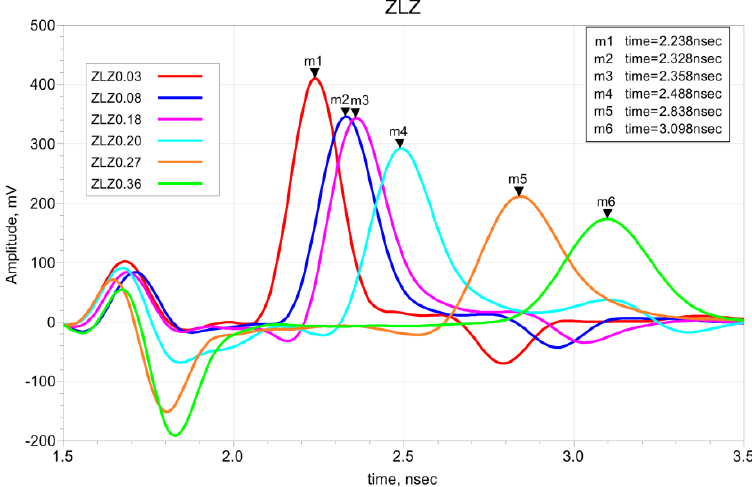
Figure 8. Examples of waveforms in the time domain from ADS for ZLZ soil samples with different θ values.